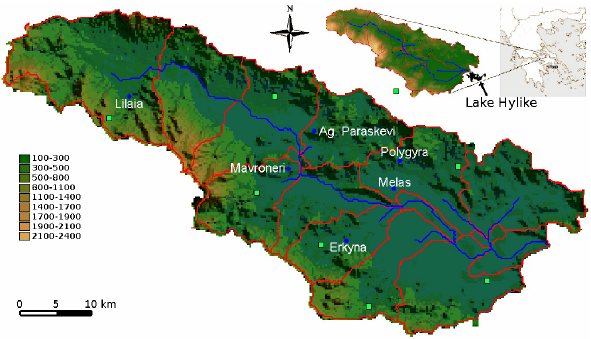
Fig. 2. The Boeoticos Kephisos river basin and the main hydrosys- tem components, i.e., sub-basins, river network, springs (circles) and rain gauges (rectangles), according to the schematization of modelling framework B. The basin location is also shown (upper